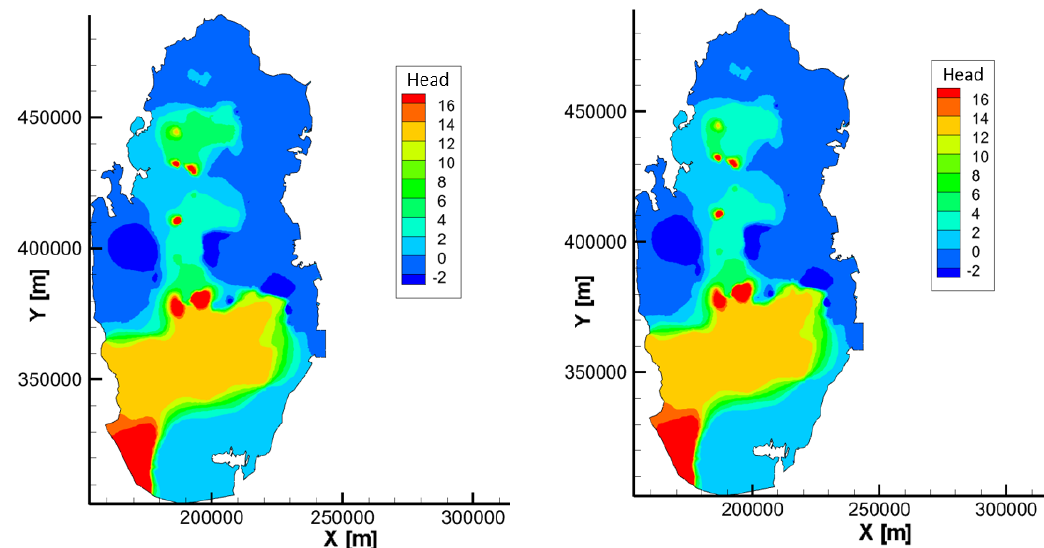
Figure 10. Steady- state piezometric heads for an injection rate of 5.1 Mm 3 /year and a porosity of 0.02 (on the left). Steady- state piezometric heads for an injection rate of 1.6 Mm 3 /year and a porosity of 0.08 (on the right).